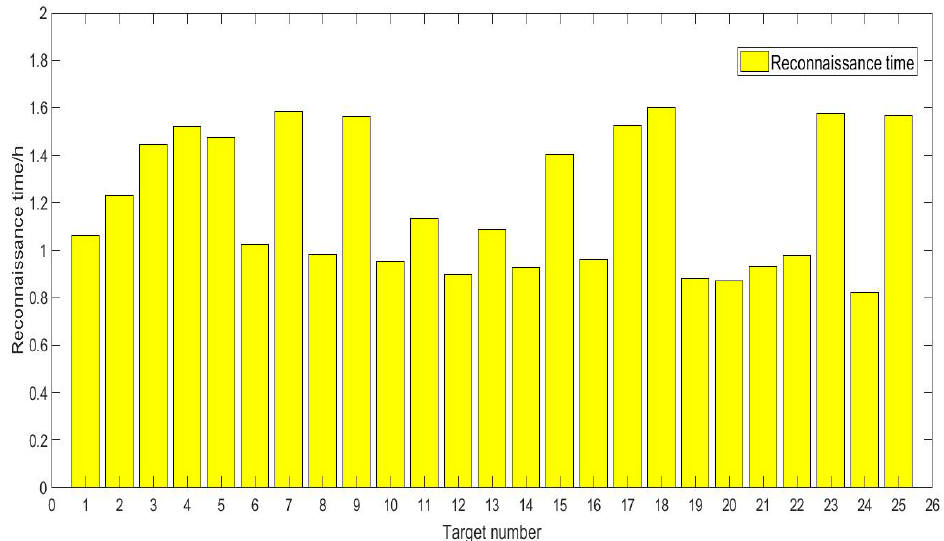
Figure 3. Reconnaissance time of each target area in the section.